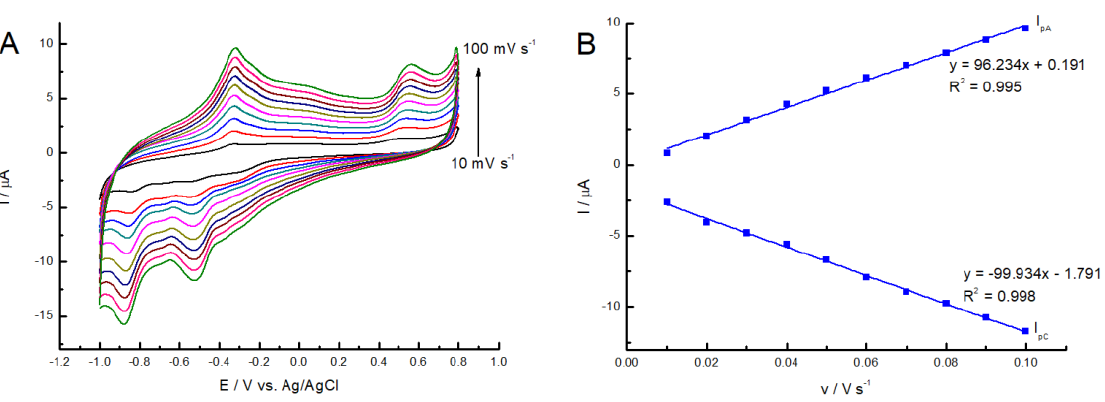
Figure 3. ( A ) Cyclic voltammograms of GC/MWCNTs/ Pz3 modified electrodes in phosphate buffer (pH 7.4) at 10 – 100 mV s −1 scan rate. ( B ) Dependence of the scanning rate on the peak current Ip.